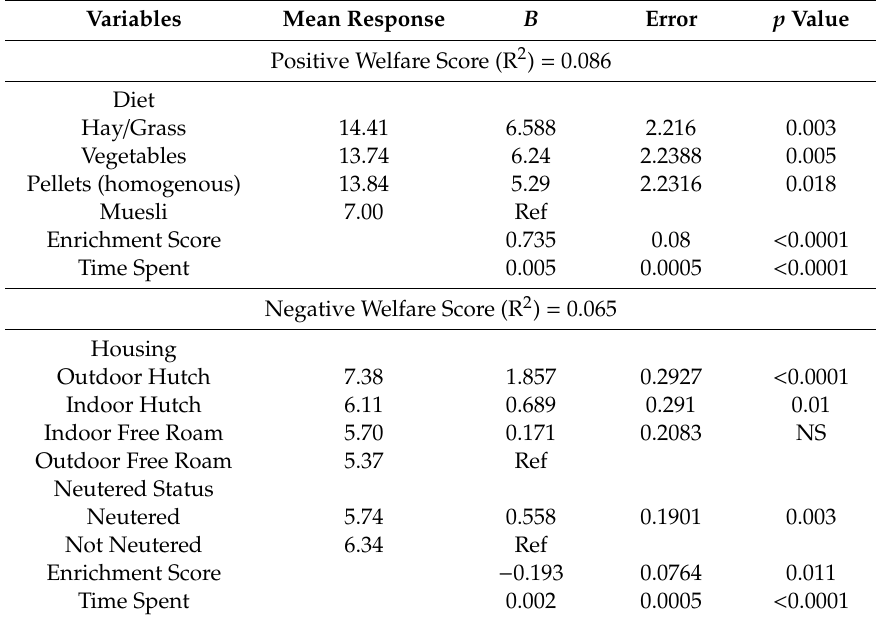
Table 5. Results from generalized linear model for housing, diet, enrichment score, neutering, partner, and time spent with positive and negative welfare